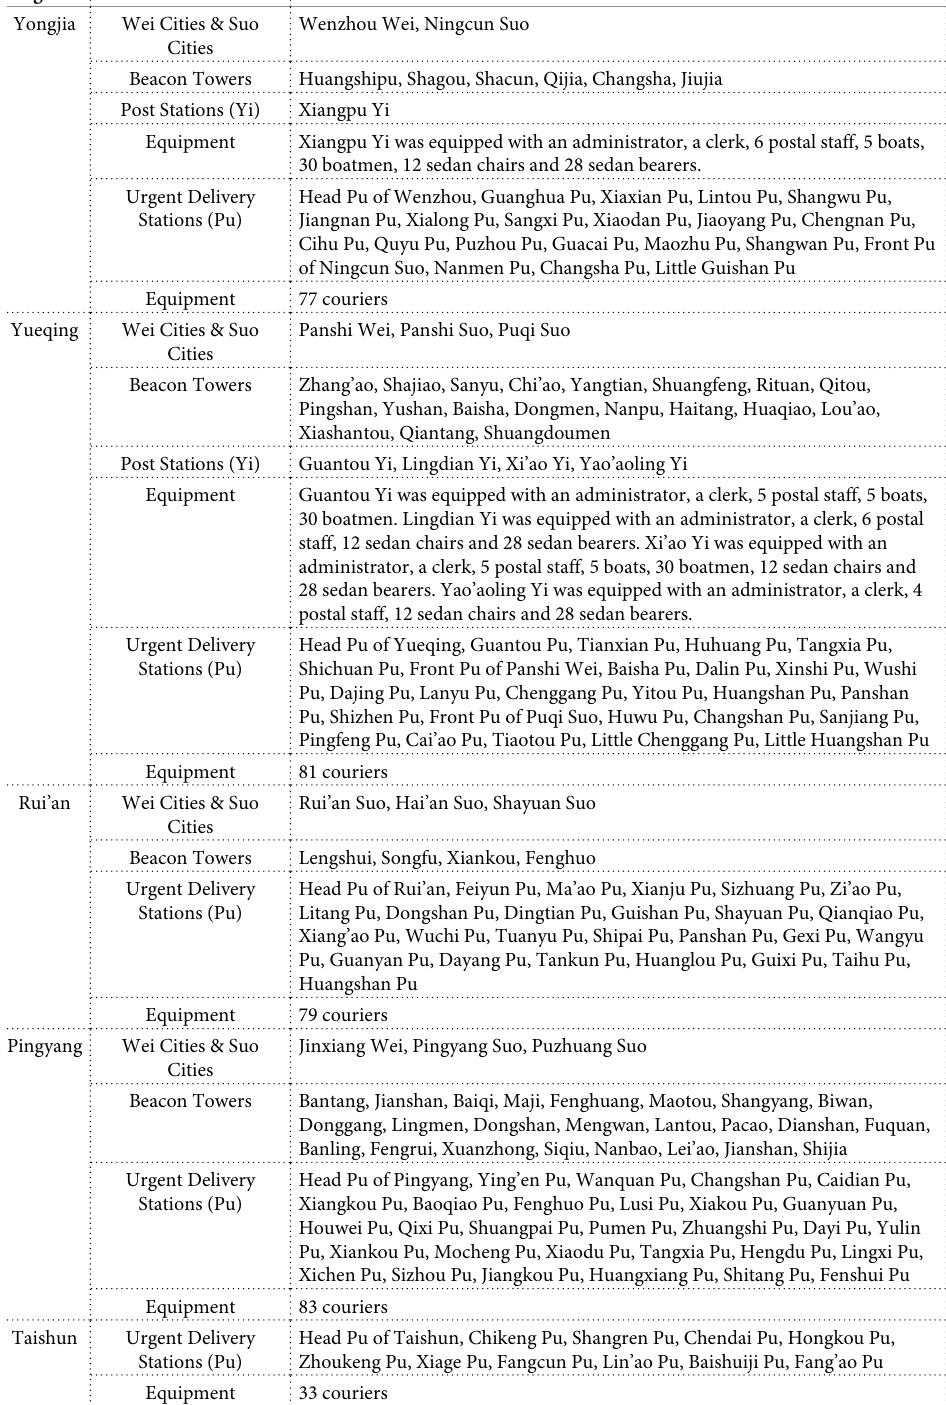
Table 2. Wei cities, Suo cities, beacon towers, post stations and urgent delivery stations